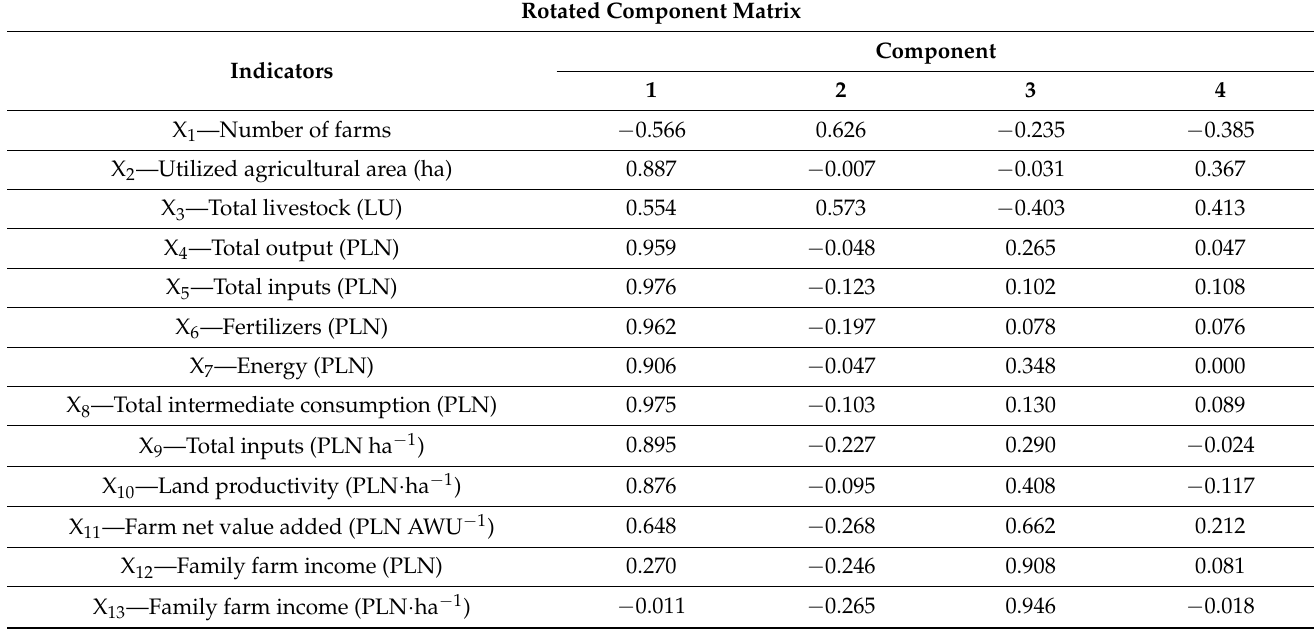
Table A5. Eigenvalues and proportions of total variance in 15 years as explained by the first four principal components for original traits and correlation coefficients between these traits and the first four PCs on mixed production